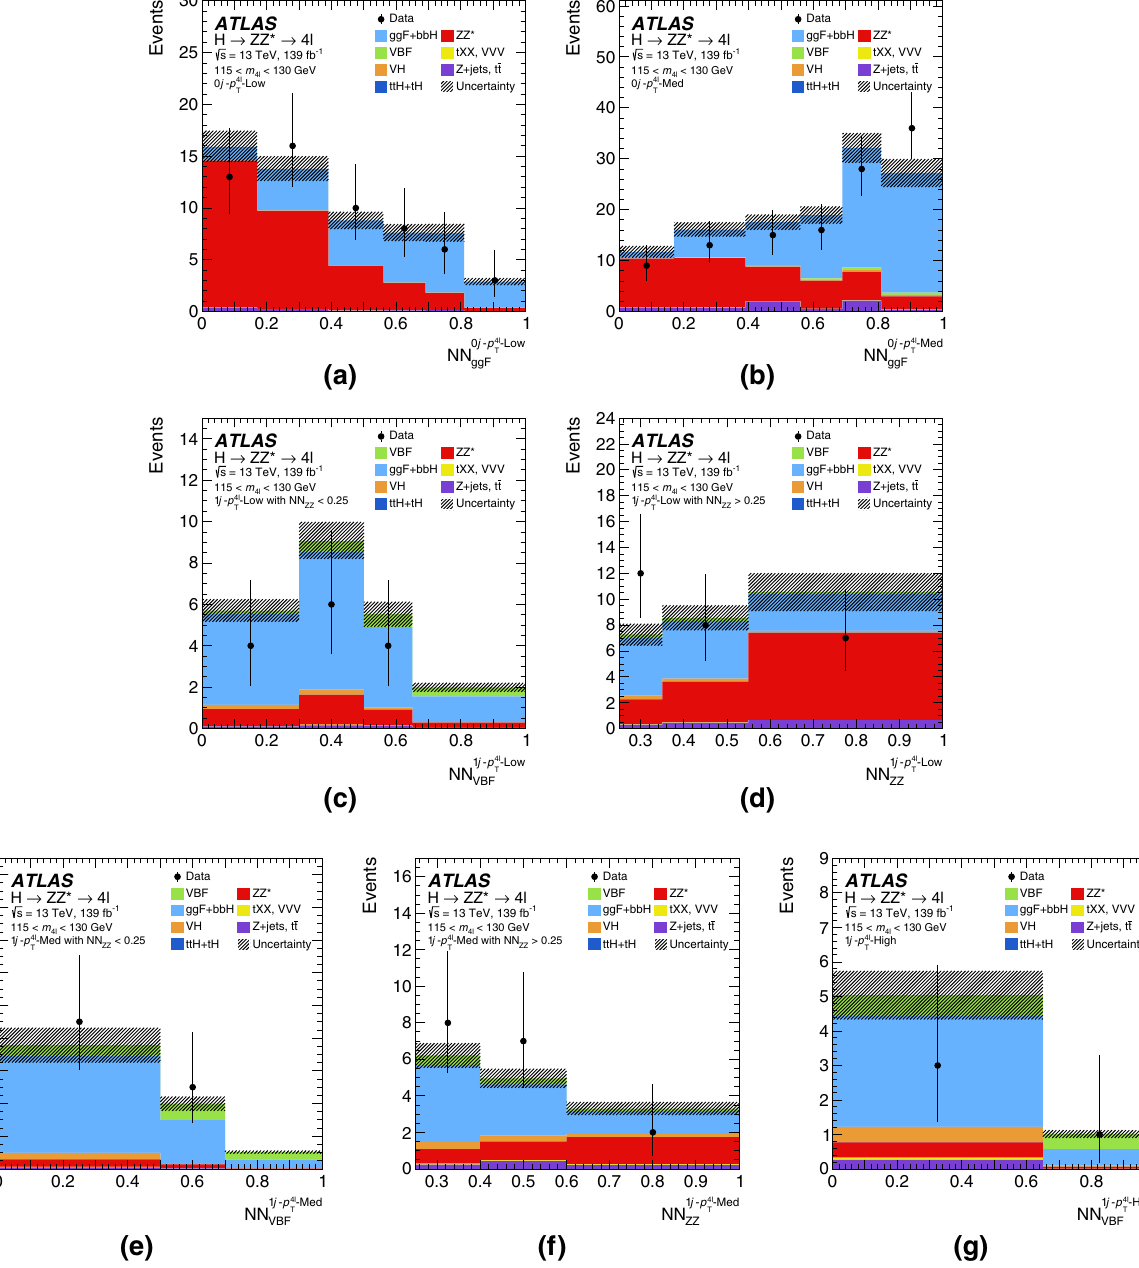
Fig. 7 The observed and expected NN output (post-fit) distributions -High. The SM Higgs boson signal is assumed to have NN VBF in 1 j - p 4 (cid:4) √ T for an integrated luminosity of 139 fb − 1 at amass m H =125GeV.Theuncertaintyinthepredictionisshownbythe s = 13 TeV in the different zero- and one-jet categories: ( a ) NN ggF in 0 j - p 4 (cid:4) hatched band, calculated as described in Sect. 7. For comparison only, -Low, ( b ) NN ggF in T the hatched band includes the theoretical uncertainties in the SM cross- -Med, ( c ) NN VBF 1 j - p 4 (cid:4) -Low with NN ZZ < 0 . 25, ( d ) NN ZZ 0 j - p 4 (cid:4) T T section for the signal and the background processes. The bin boundaries in 1 j - p 4 (cid:4) -Low with NN ZZ > 0 . 25, ( e ) NN VBF in 1 j - p 4 (cid:4) -Med with T T are chosen to maximise the significance of the targeted signal in each NN ZZ < 0 . 25, ( f ) NN ZZ in 1 j - p 4 (cid:4) -Med with NN ZZ > 0 . 25 and ( g ) T